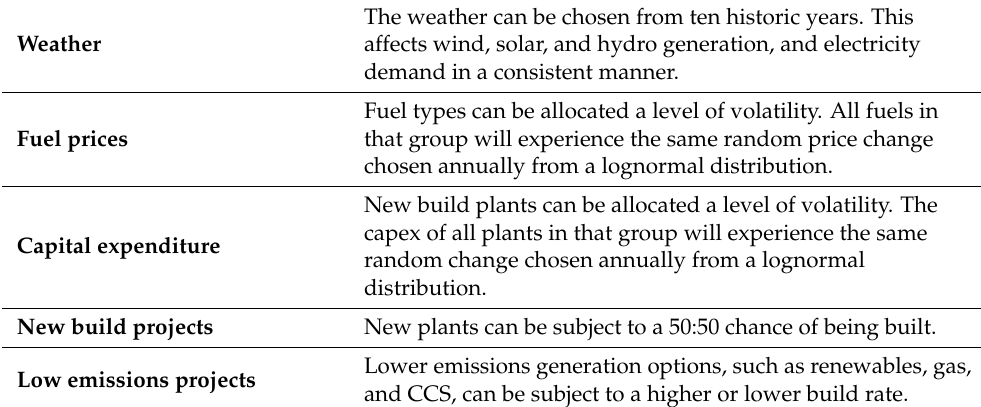
Table 1. S-MEGS Uncertainty